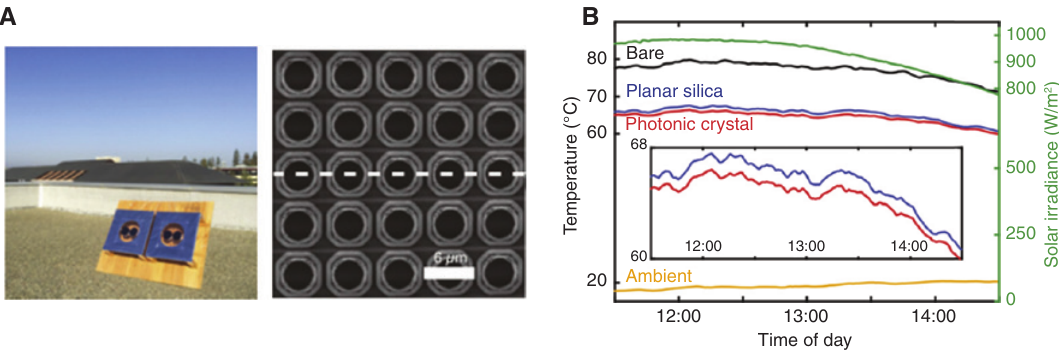
Figure 9: (A) Experimental setup for radiative cooling in [19]. The left picture shows the apparatus and solar absorbers on a rooftop. The chambers were tilted at 60 ° to maximize solar absorption. Shown on the right is the normal view SEM image of the 2D silica photonic crystal structure (PhC) consisting of a square lattice PhC of 10 μ m deep air holes with a periodicity of 6 μ m fabricated on a fused silica wafer. (B) Temperature measurement of solar absorbers underneath different top layers on a clear day in winter. The measurement was performed with a windshield to reduce the convection coefficient to 6.5–9.1 W/(K m 2 ).